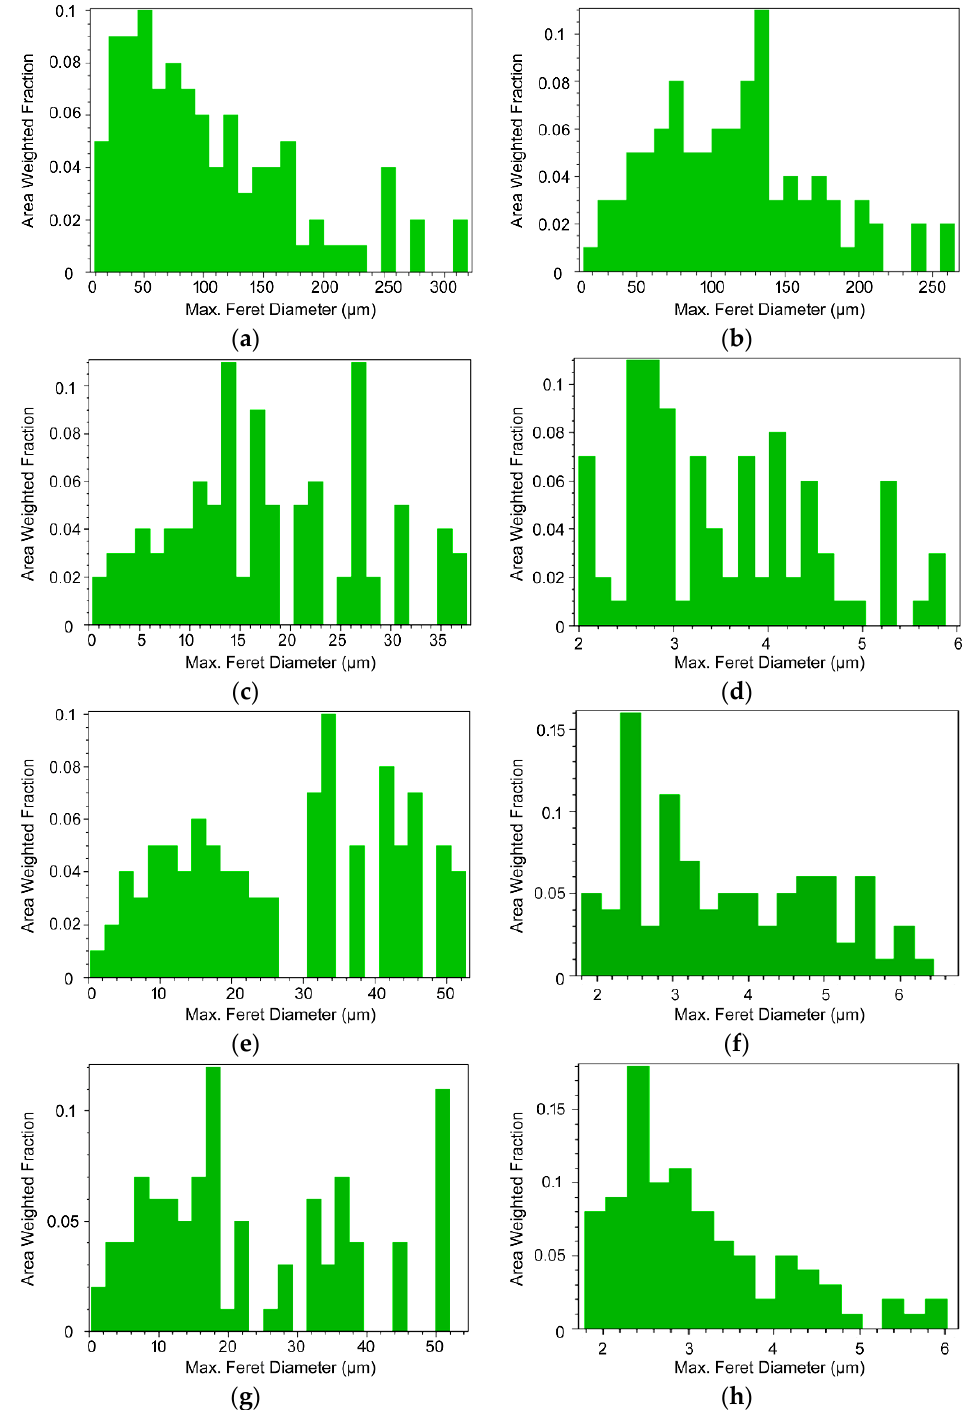
Figure 8. Grain size distributions for original metals: CP Cu ( a ), CP Al ( b ). Grain size distributions for swaged laminate: Cu lamella ( c ), Al matrix ( d ); HT1 laminate: Cu lamella ( e ), Al matrix ( f ); HT2 laminate: Cu lamella ( g ), Al matrix ( h ).